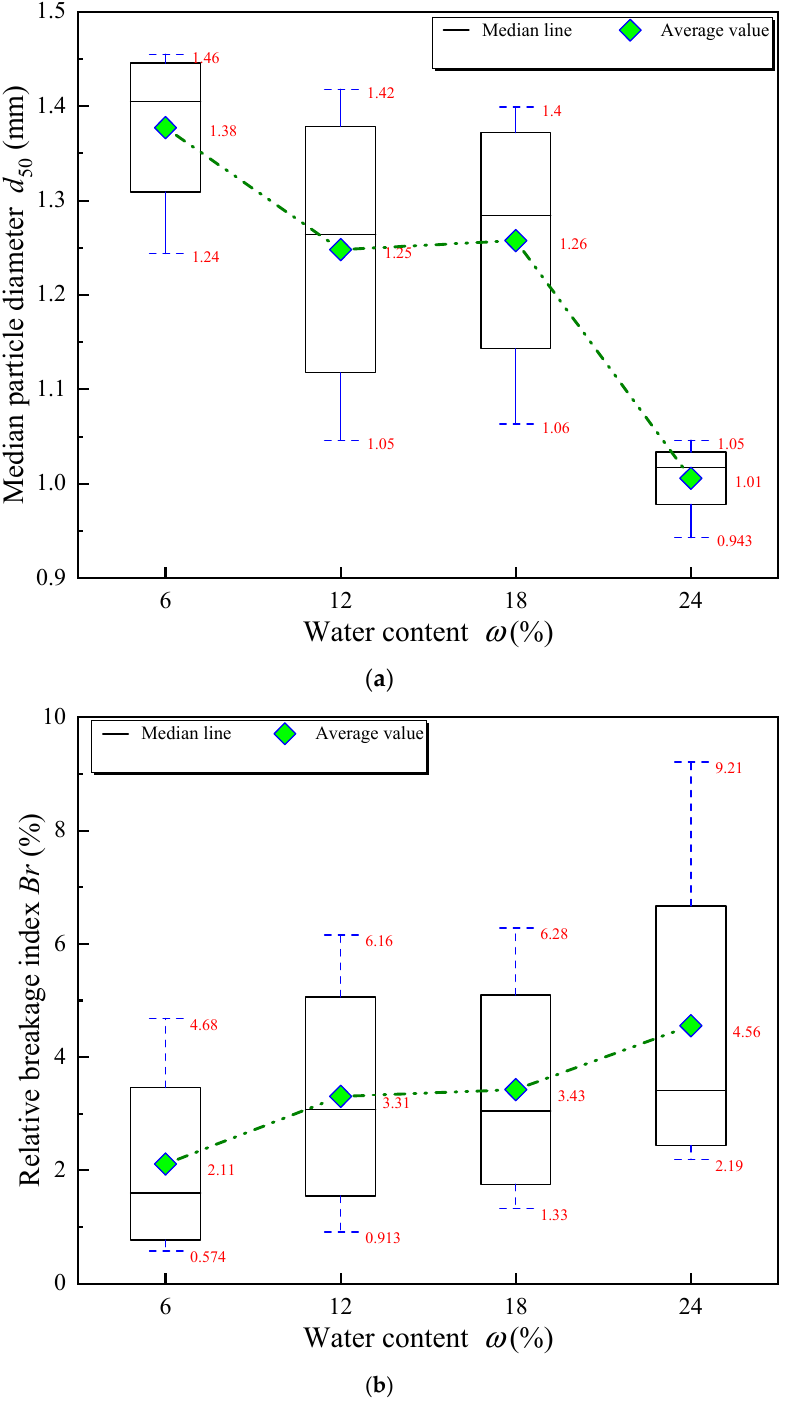
Figure 11. Particle breakage amount versus water content of coral gravelly sand: ( a ) Median particle diameter versus water content; and ( b ) relative breakage index versus water content.